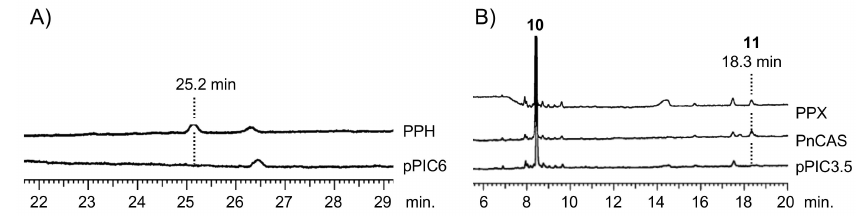
Figure 2. GC analysis of PPH ( A ) and PPX ( B ) products. ( A ) Gas chromatograms of triterpene mono-alcohol fraction from yeast transformants with PPH and pPIC6 (empty vector). Retention time of the PPH product was 25.2 min. ( B ) Gas chromatograms of triterpene mono-alcohol fraction from in vitro reaction of racemic 2,3-oxidosqualene ( 10 ) with recombinant PPX, CAS derived from Polypodiodes niponica (PnCAS), and empty vector (pPIC3.5). Retention time of the PPX and PnCAS product was 18.3